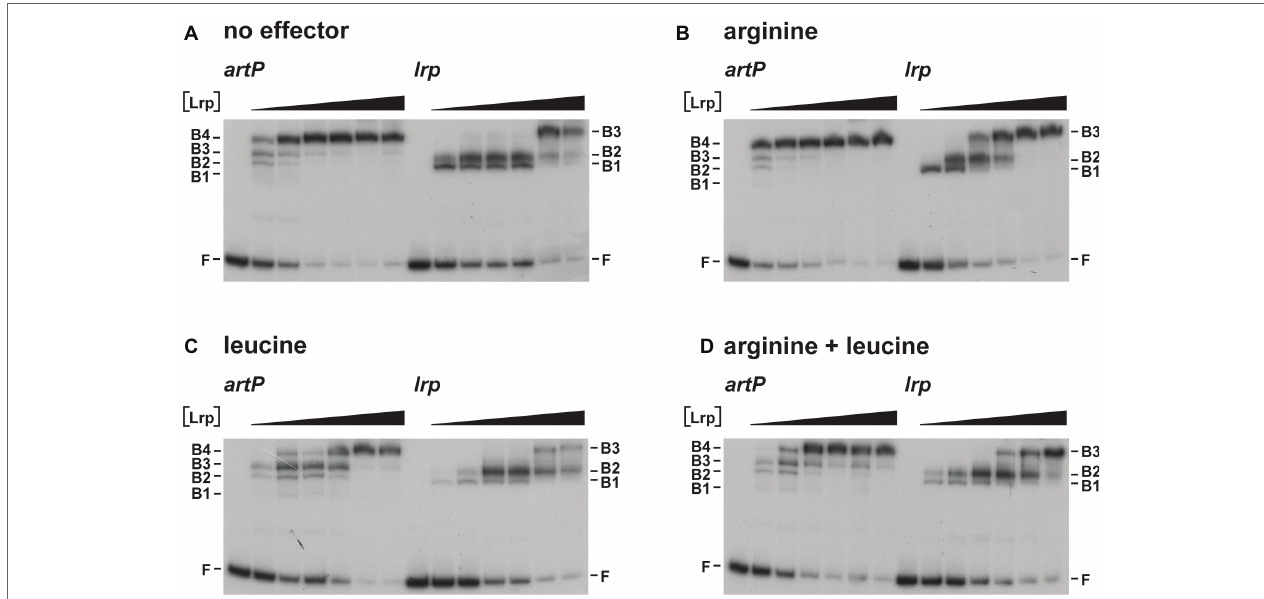
FIGURE 4 | Representative autoradiographs of Lrp binding to the artP and lrp control regions in the absence (A) and in the presence of 10 mM l -arginine (B) , 10 mM l -leucine (C) or 10 mM of both (D) , as indicated. Lrp concentrations (black colored triangle) correspond to 0, 0.23, 0.46, 0.92, 1.84, 3.68, and 7.36 μM (expressed in monomer equivalents). The position of the free DNA fragments (F) and the Lrp-bound DNA fragments (B1, B2, B3) are